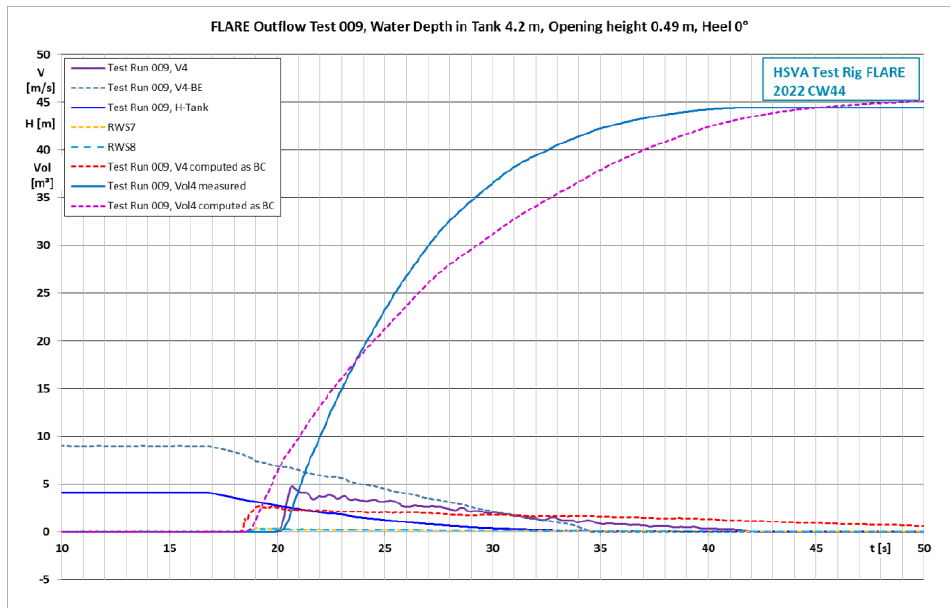
Figure A5. Flow speed V 4 and water elevations RWS7 and RSW8 at the fourth section S 4 for the test run 009 as earlier. In addition, the water discharge volumes Vol 4 based on the flow speed V 4 computed with BE and based on the measured flow speed V 4 are shown. These two curves coincide only in this particular case.